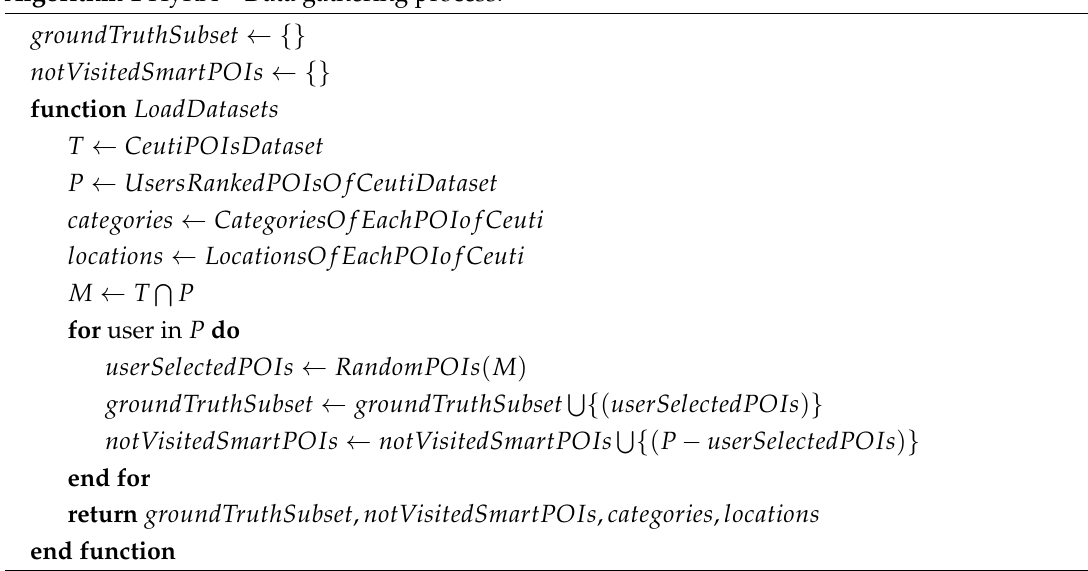
Algorithm 1 HyRA—Data gathering